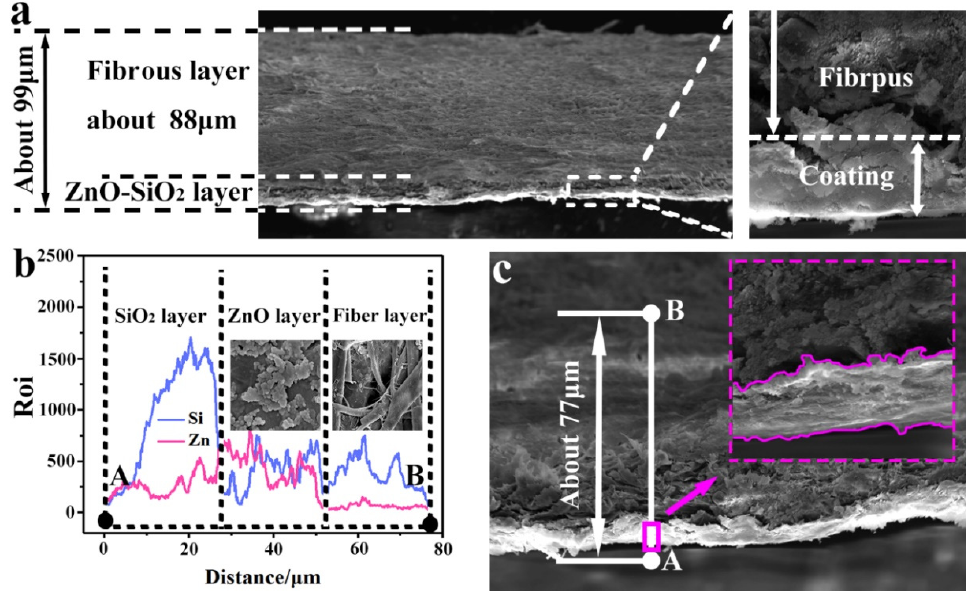
Figure 6. ( a ) Sectional view of coated paper, ( b ) Elemental permeation distribution between coated papers AB, ( c ) Enlarged sectional view of coated paper.